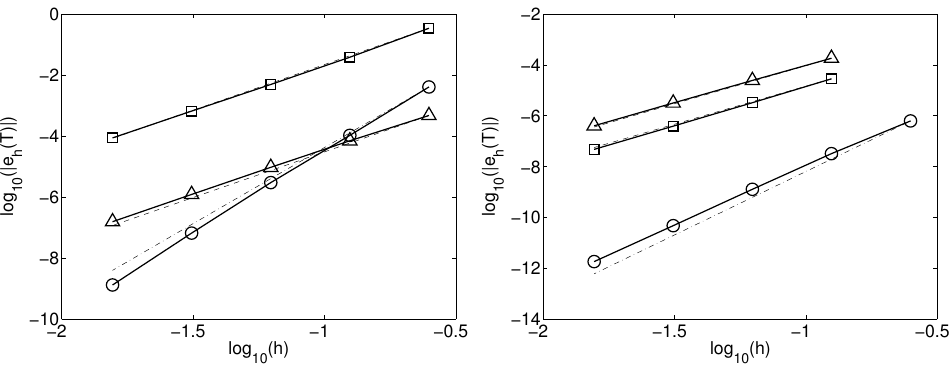
Figure 2. Error of two-step methods TS3 ( (cid:3) ), TS3b ( (cid:77) ) and TS5 ( ◦ ), and slopes of order 3 (dashed line) and of order 5 (dash-dot line), applied to problem (61) (left) and on problem (62)